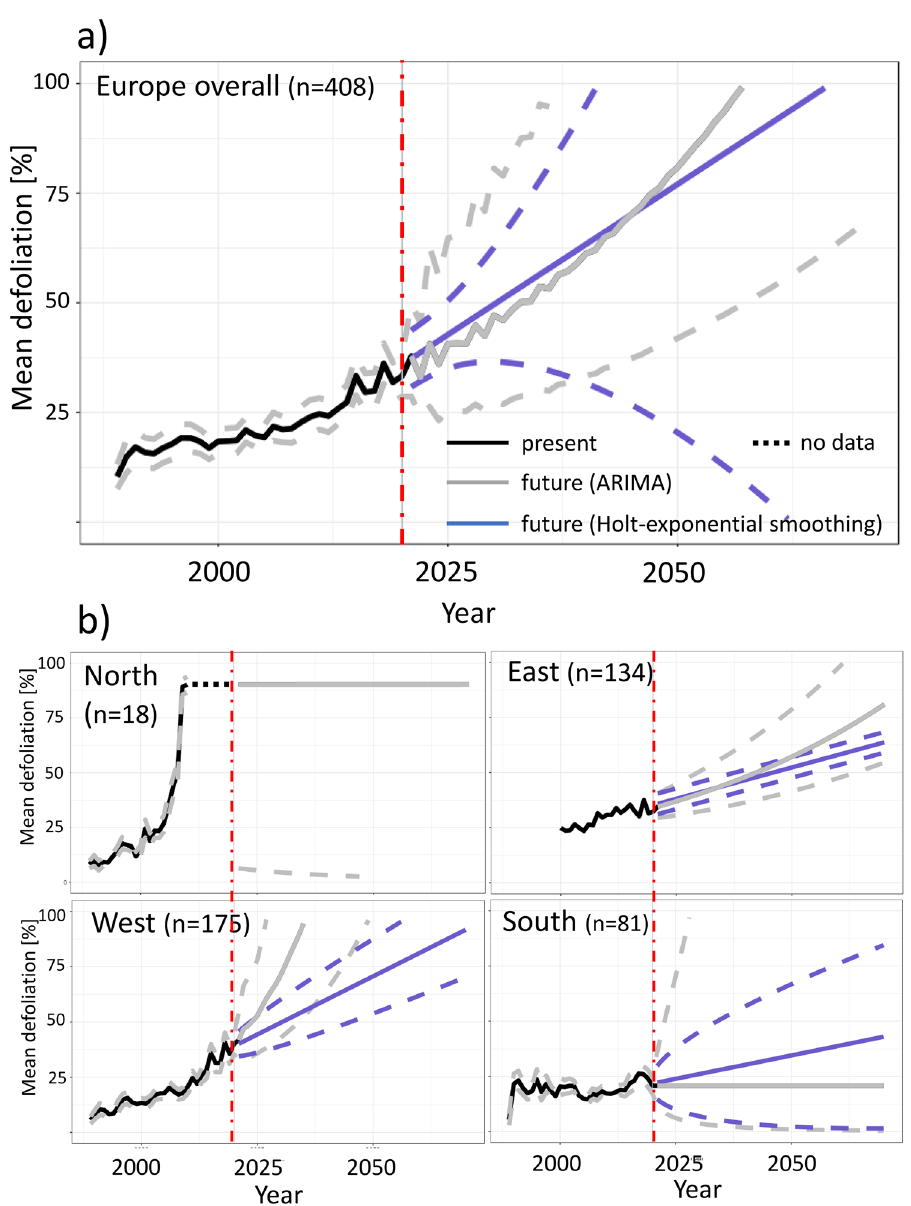
Scandinavia and is therefore not displayed in the northern